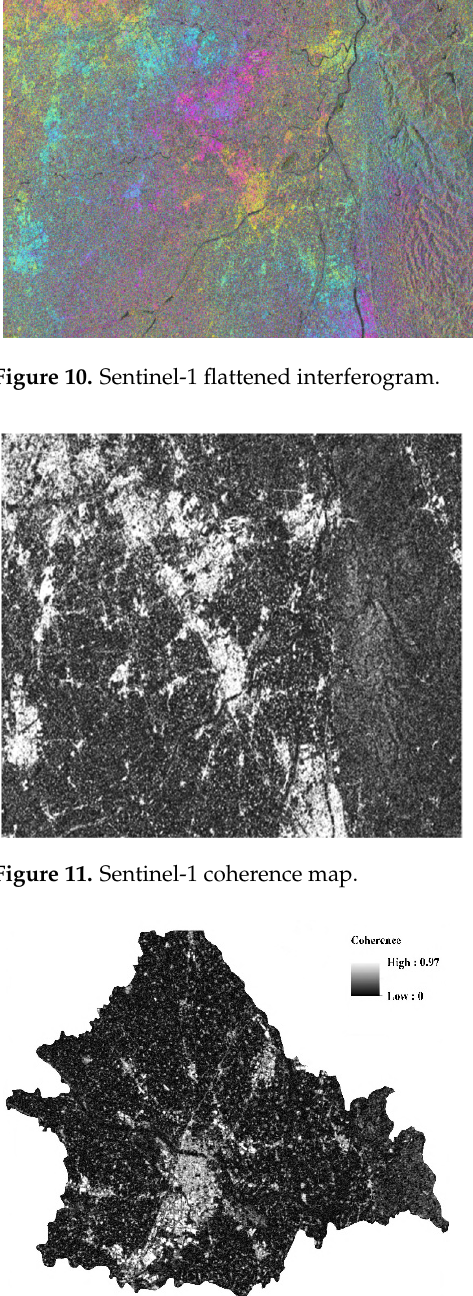
Figure 9. Sentinel-1 interferogram.